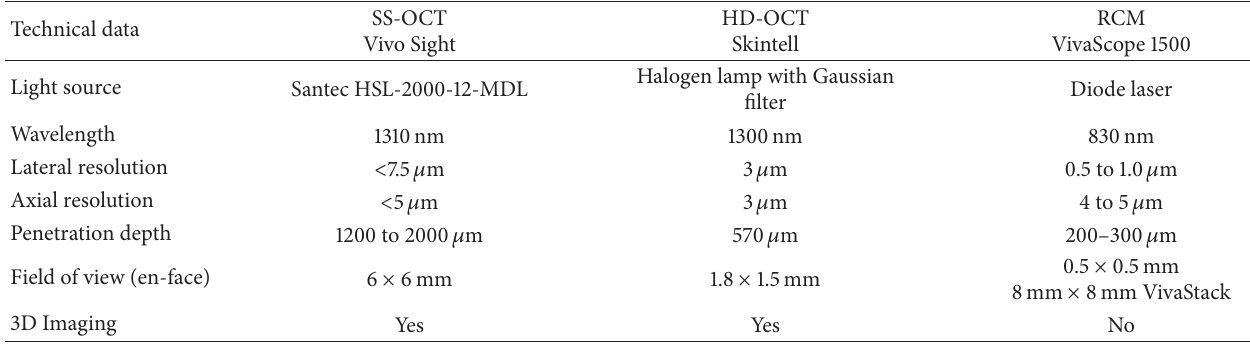
Table 2: Technical data on swept source-optical coherence tomography, high definition-optical coherence tomography, and reflectance confocal microscopy.